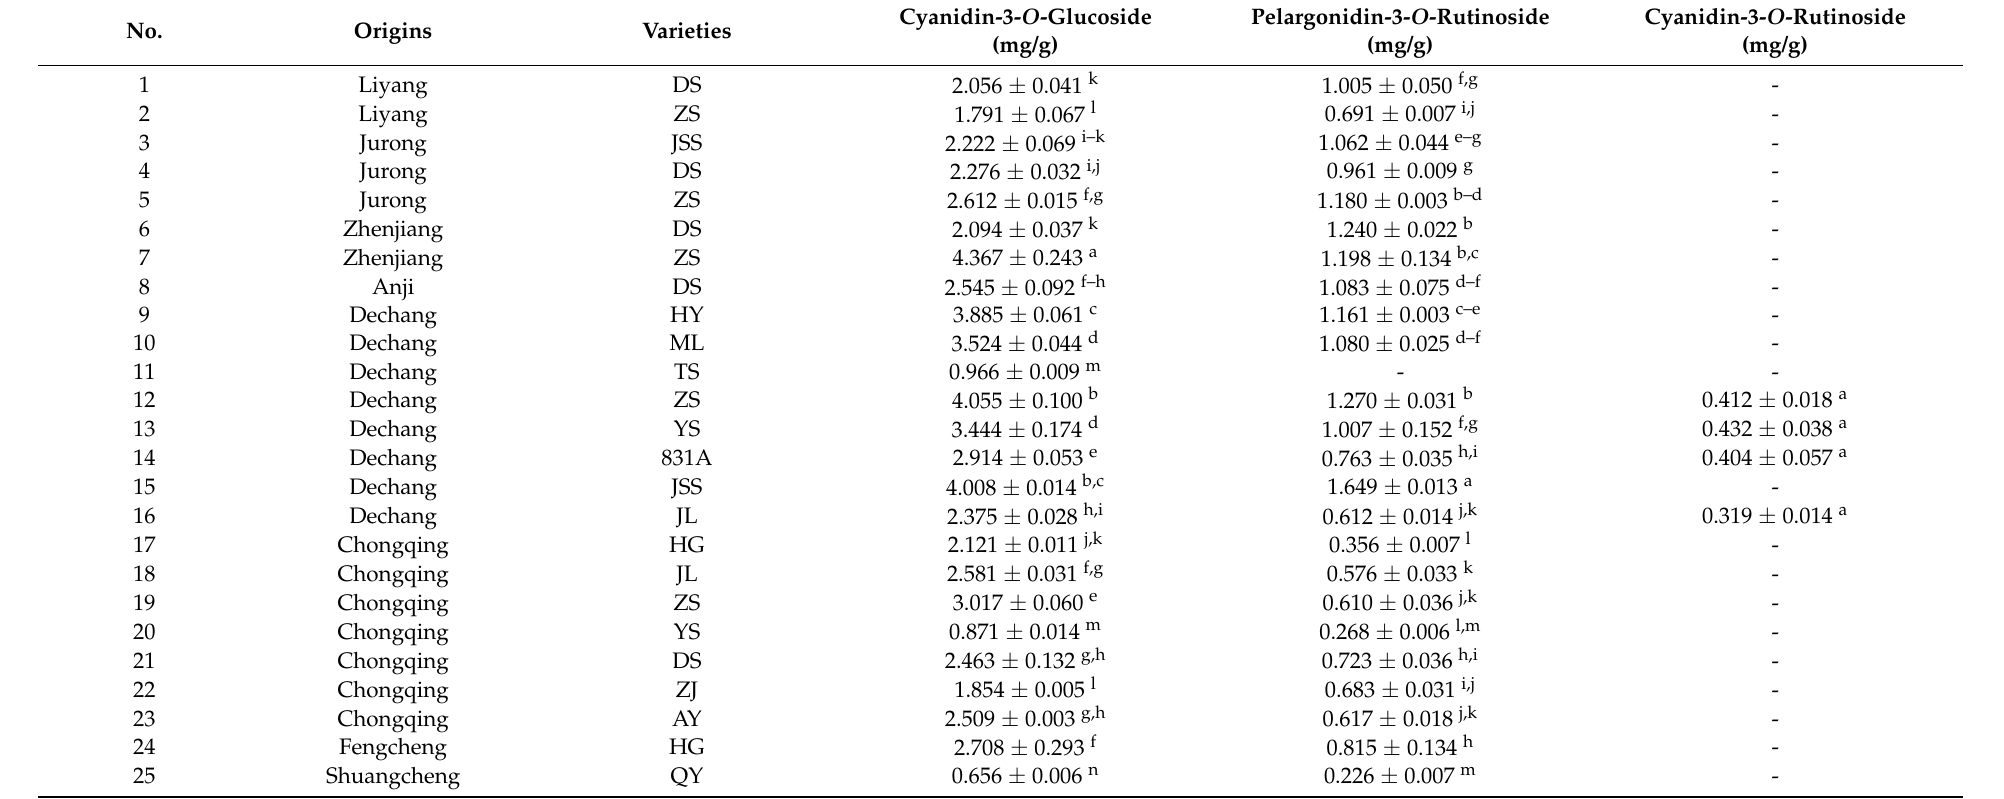
Table 3. The content of main anthocyanins in mulberry fruits among varieties from different areas in